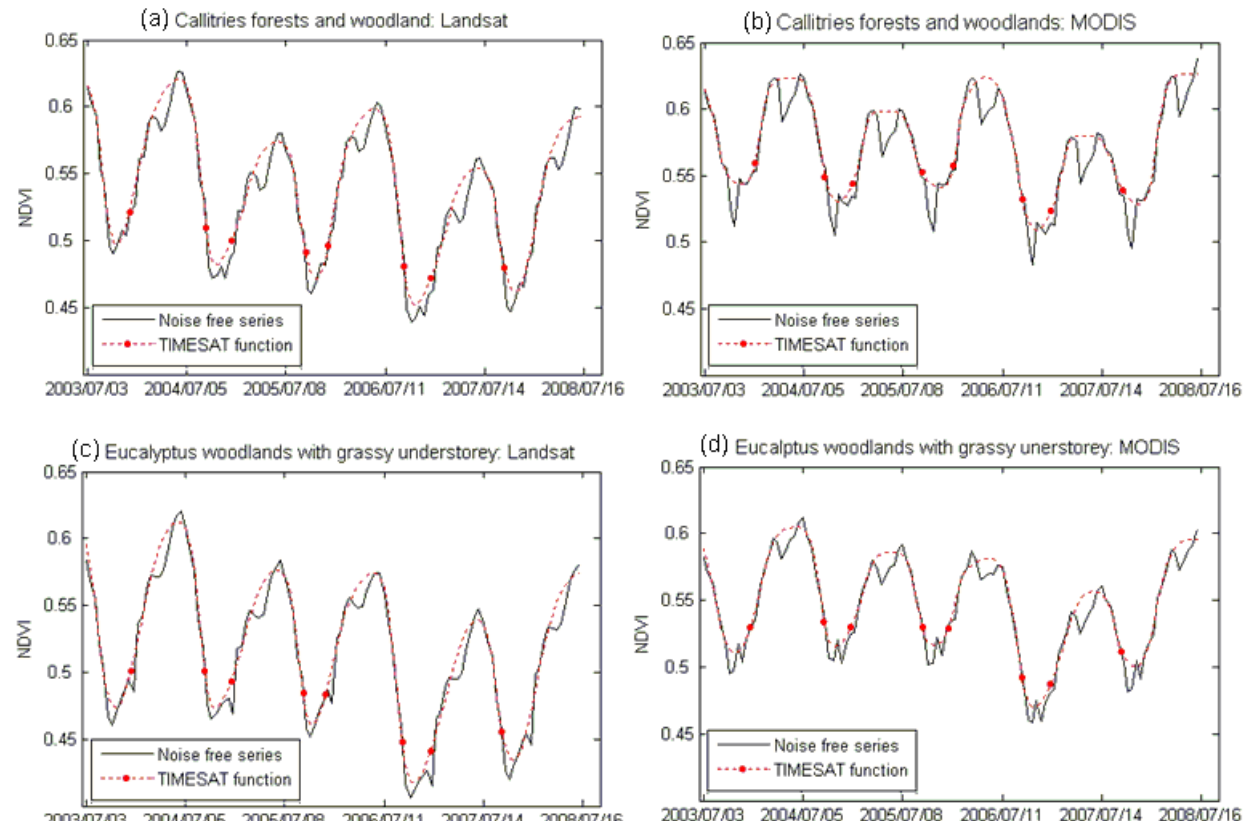
Figure 10. Extraction of seasonal parameters from Landsat TM and MODIS NDVI time series using the TIMESAT program. ( a ) and ( b ) Callitris forests and woodlands; ( c ) and ( d ) Eucalyptus woodlands with grassy understorey. The polynomials were fitted in noise free NDVI series using the Logistic function available in TIMESAT. The dots in the fitted polynomials indicate the start and end points of respective